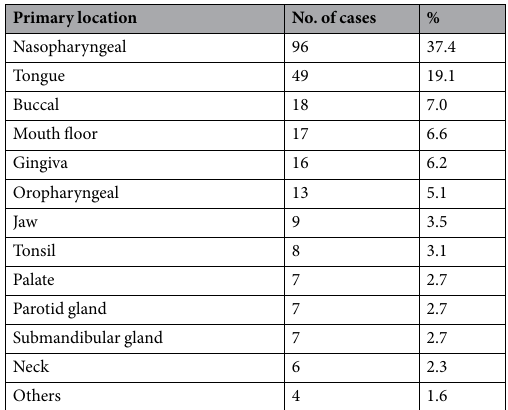
Table 2. Primary tumor before radiation.